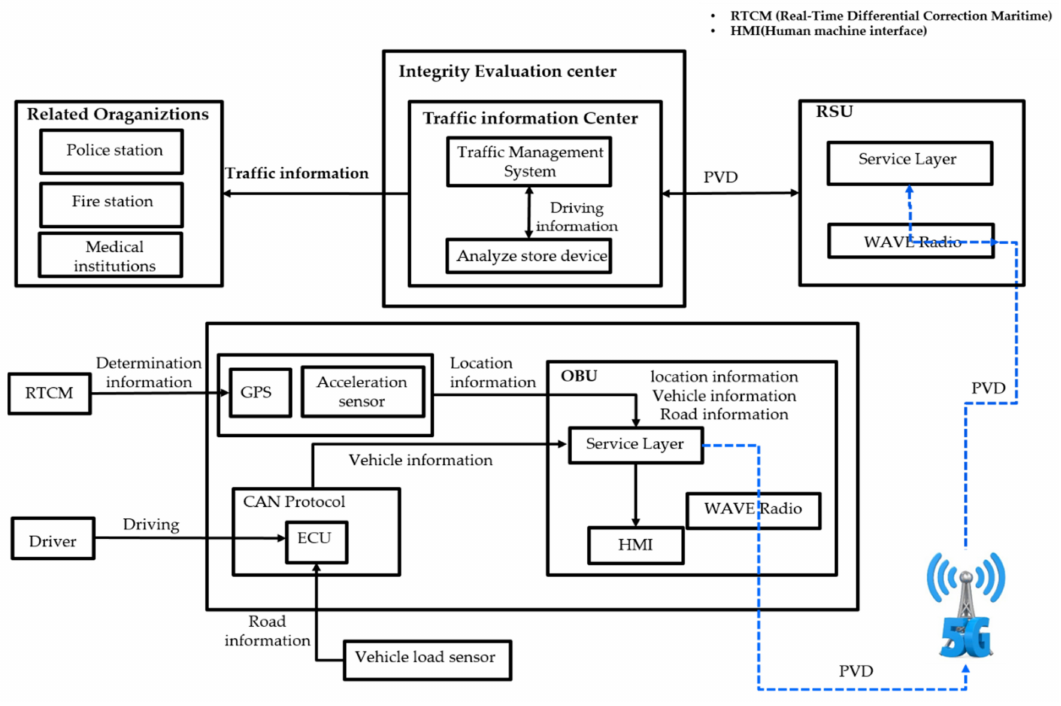
Figure 1. Location-Based Vehicle Data Collection